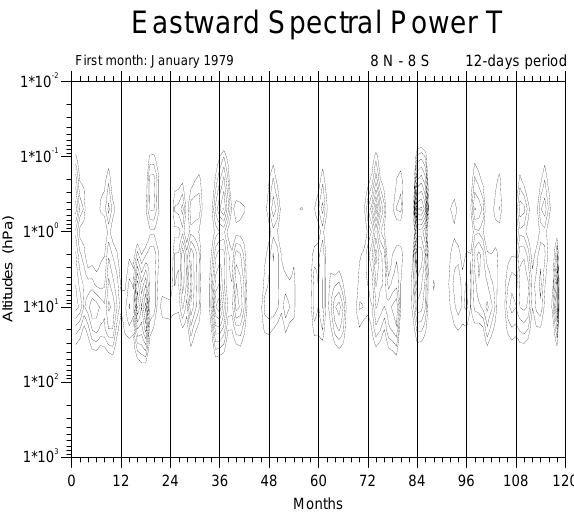
Fig. 1 Fig. 1. Time series over 10 years of the spectral power of tempera- ture fluctuations of zonal-wave number 1 and 12-day period during the period January 1979 to October 1988. The contour interval is 1.5 K 2 day. First contour is 7.5 K 2 day. The power spectrum is de- [ 2 | A k, ± w |] 2 1T ; where A k, ± w is the com- fined as: P k, ± w (A) = 1 2 plex space-time Fourier transform of the serie A(x,t) , k and w are wavenumber and frequency and 1T is the observationnal